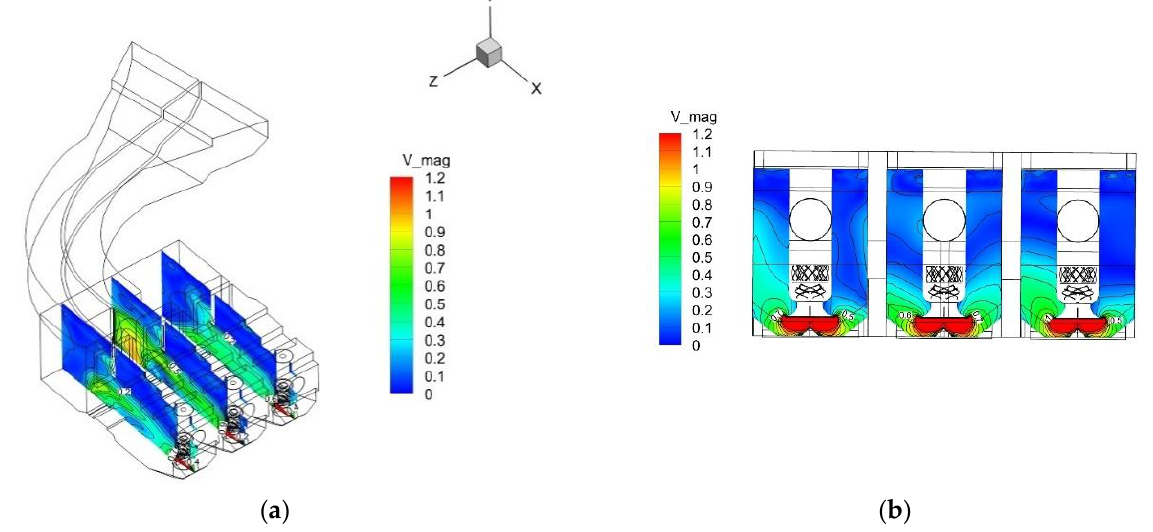
Figure 12. Plan 4 isogram of velocity. ( a ) Center section of pump body along flow direction. ( b ) Center section of pump body in vertical flow direction.